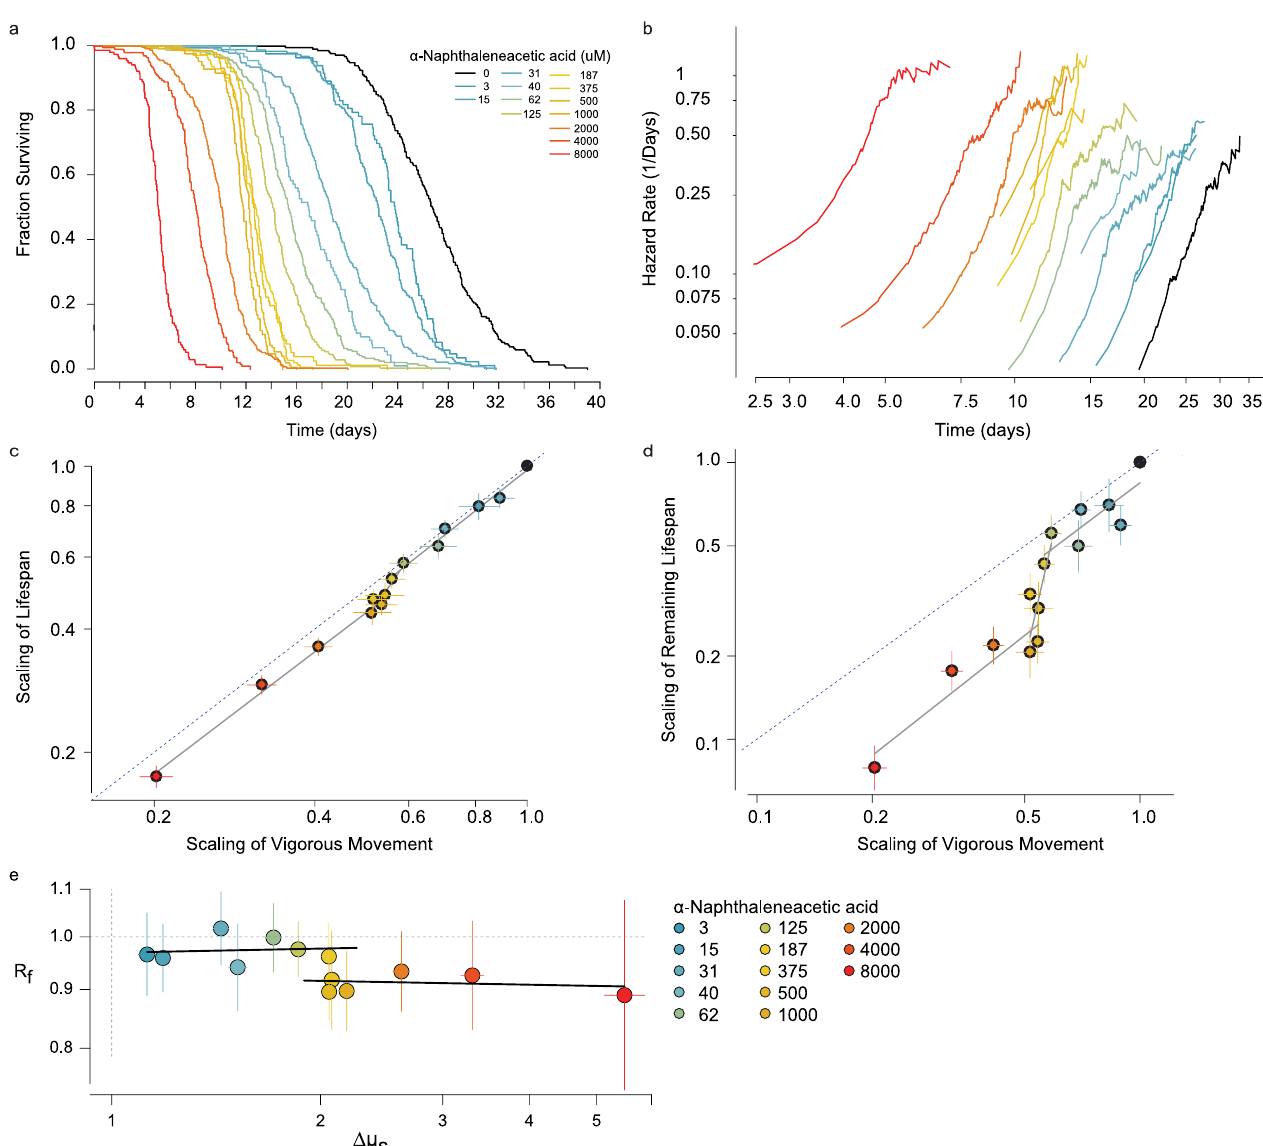
Fig 6. An RNA Polymerase II dosage series. Tunable, in vivo manipulation of RNA polymerase II activity using an rpb-2 auxin-inducible degron. A. The lifespan of rpb-2 :: AID;TIR1 populations exposed to a set of increasing concentrations of alpha-Naphthaleneacetic acid (NAA), shown as Kaplan-Meier survival curves. b. The time-dependent trajectory of the risk of death calculated for the same populations. c. At each dosage, the effect of NAA on the time of vigorous movement cessation and lifespan are compared. Error bars indicate 95% confidence intervals of AFT regression parameter estimates. Data was fit by a tri- phasic linear model (grey lines; statistical methods). Dotted line indicates the x = y unity line. d. The same analysis, but comparing vigorous movement cessation to remaining lifespan. e. Estimates of R f and Δ μ , quantifying the magnitude of disproportionate and proportionate effects of each NA concentration on VMC and lifespan (S5 text; Statistical methods). Error bars indicate 95% confidence intervals. Black lines indicate linear fits to each concentration range; < 187 μ M and > 375 μ M.